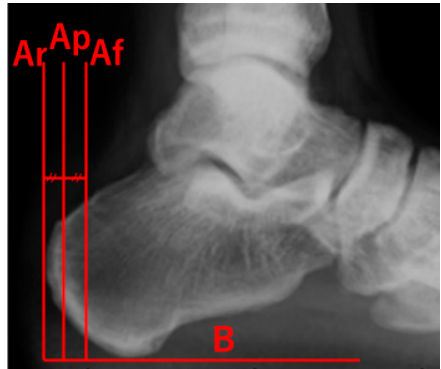
Figure 4. B: Plantar axis. Af: Front edge of the Achilles tendon insertion. Ar: Rear edge of the Achilles tendon insertion. The central axis of Ar and Af was defined as Ap (the central axis of post-operated Achilles tendon insertion).